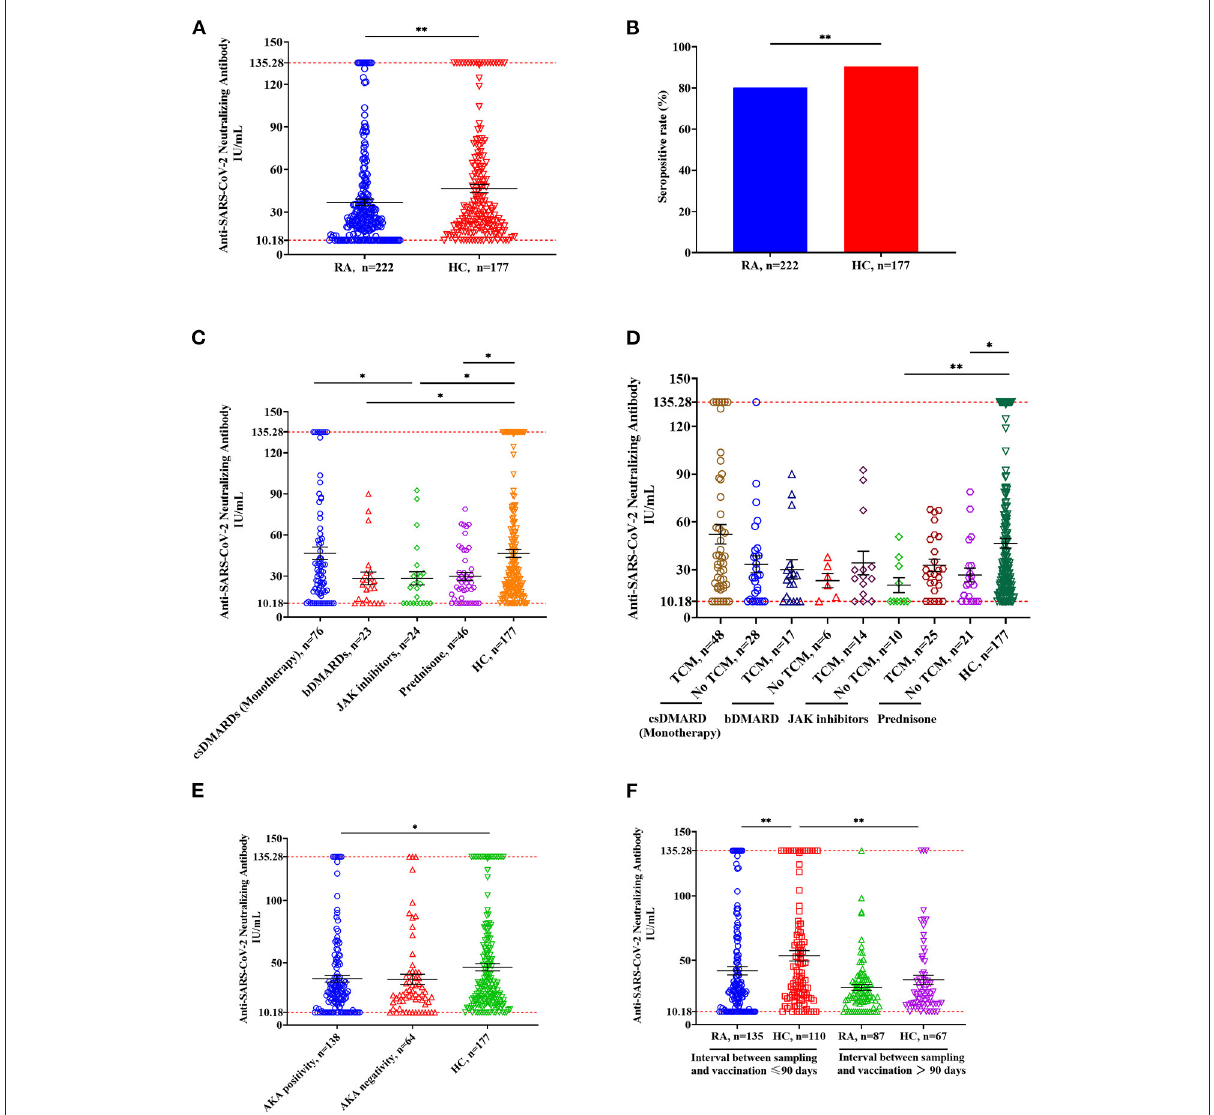
FIGURE2 Anti-SARS-CoV-2 NAbs responses from RA patients and HC. (A) NAb titers in RA patients ( n = 222) and HC ( n = 177). Symbols show individual values, and the red line shows the maximum value, and the black horizontal bar shows the median. Statistical analysis was performed using the Mann-Whitney U test. (B) Seropositive rates in RA patients and HC. Statistical analysis was performed using the χ ² test. (C) Effects of immunomodulatory drugs on NAb titers. RA patients were divided into four groups based on the immunomodulatory drug they were using, including csDMARD ( n = 76), bsDMAD ( n = 24), JAK inhibitors ( n = 24) and prednisone ( n = 46). (D) Effects of TCM on NAb titers. Based on whether they were taking TCM, each RA group mentioned in Figure 2C was further divided into two groups including TCM and no TCM. (E) NAb titers in RA patients with anti-keratin antibody positive or negative compared with HC. (F) Comparison of NAb titers in groups having different interval time. * p < 0.05; ** p < 0.01.